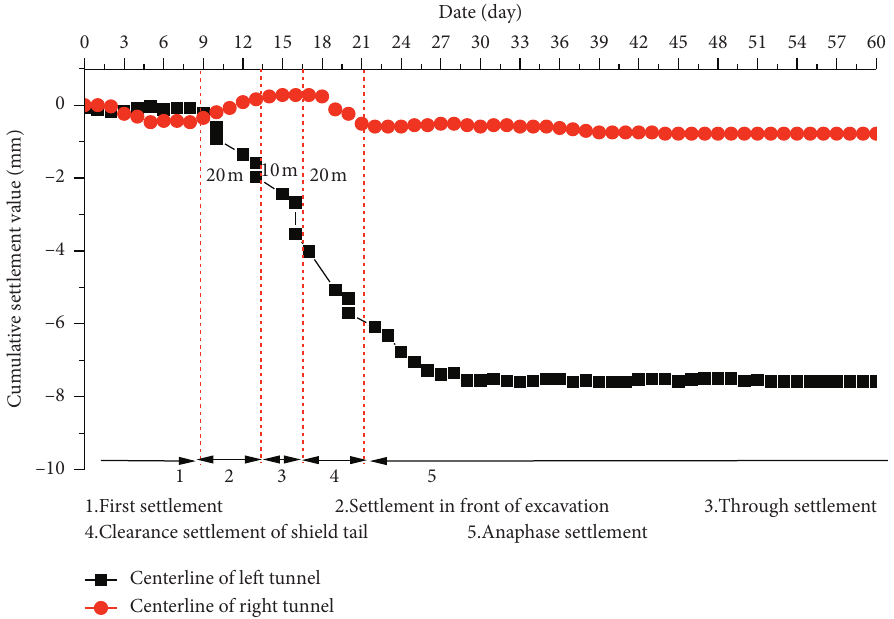
Figure 12: The settling time curve of the ground when the left-line shield passes through (test